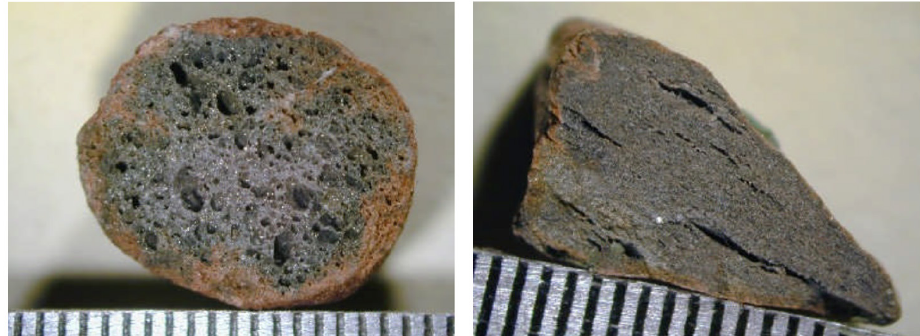
Figure 1. Typical sections of LWA [24]: a) Rounded and porous LWA, typical of expanded clay aggregates (4/10-550-A and 4/10-430-A) b) Angled and less porous LWA, corresponding to over 50% of the expanded shale aggregates (4/10-520-S and 4/8-750-S)